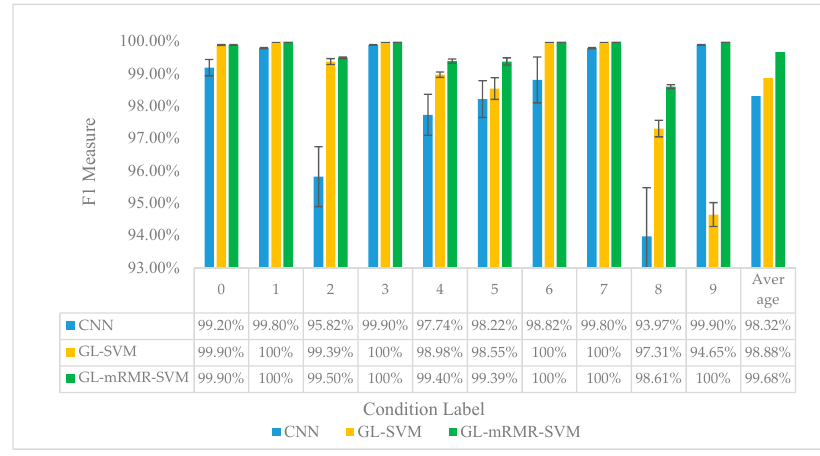
Figure 9. Diagnosis result on the testing set using different